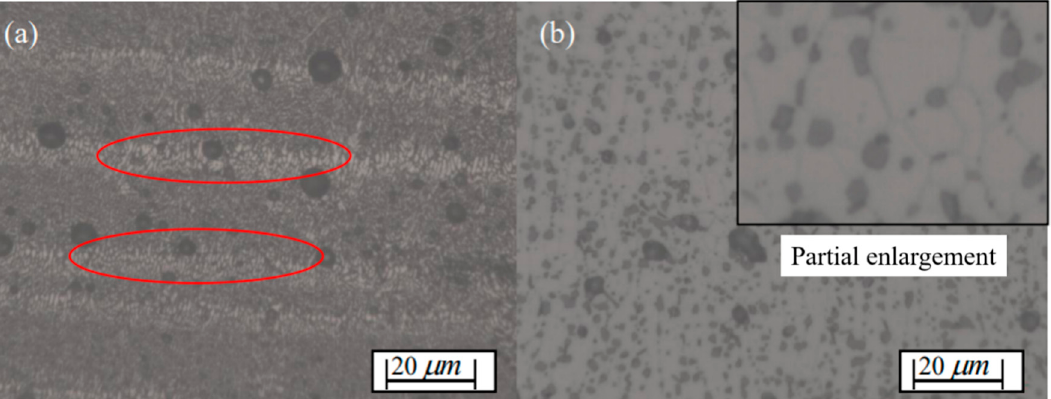
Figure 13. Microstructure of samples before and after heat treatment. ( a ) Micrograph of SLM molding parts. ( b ) micrograph of workpiece after heat treatment.